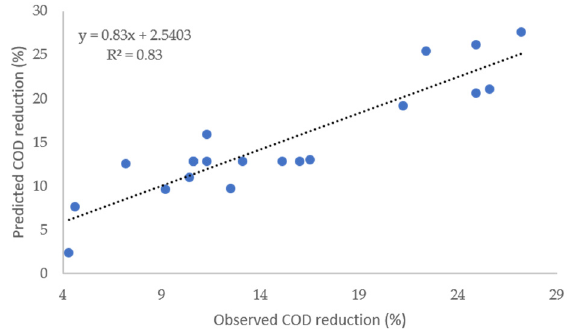
Figure 6. Observed vs Predicted value plot for COD reduction for ferrioxalate-induced solar photo-Fenton experiments in pre-treated leachate with FeCl 3 .6H 2 O coagulant.